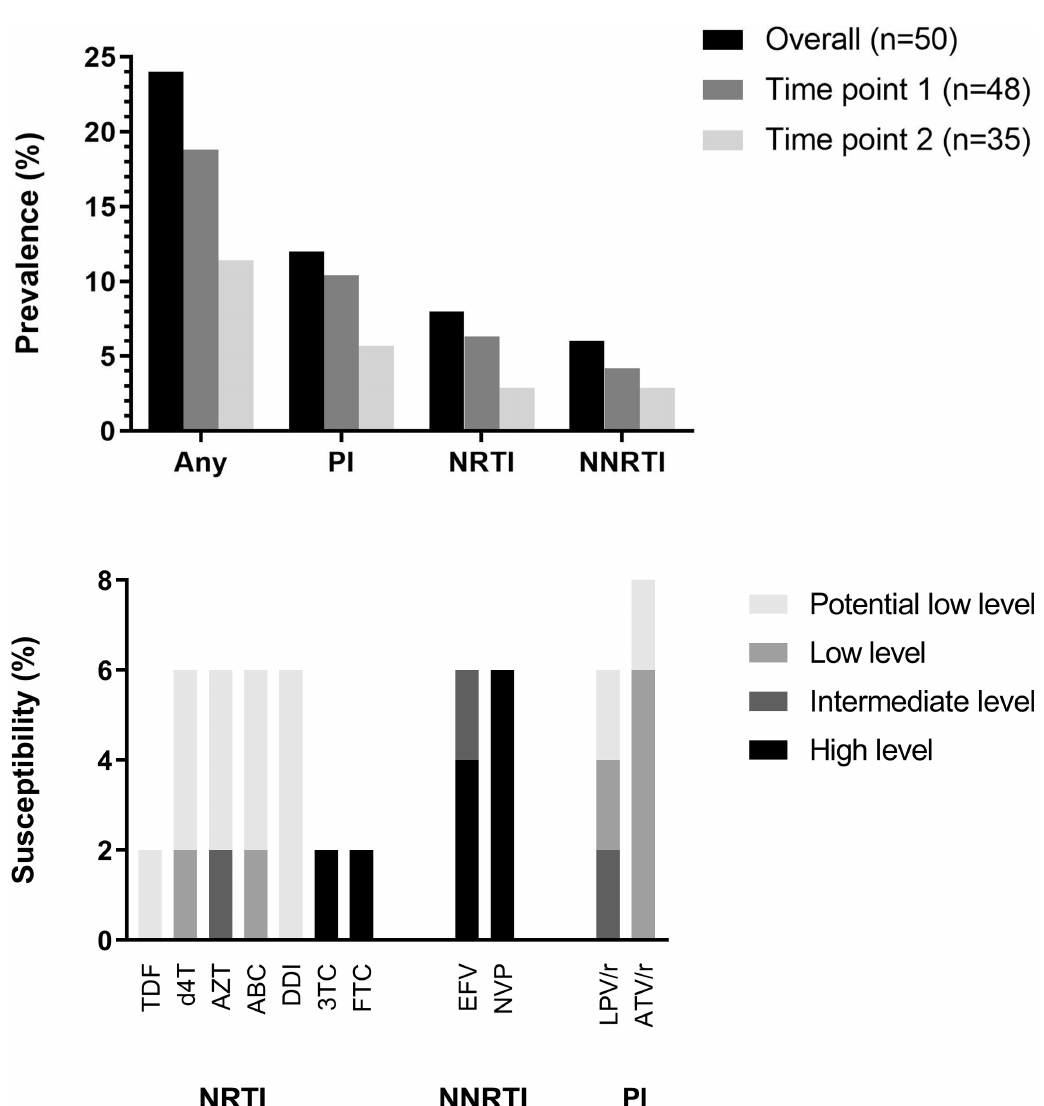
Fig 1. Bar graphs showing overall distribution of [a] HIV-1 drug resistance (HIVDR) variants by time points and drug classes, and [b] genotypic susceptibility of pre-treatment HIVDR variants detected by next generation sequencing from HIV infected antiretroviral-na ï ve individuals in a rural clinic in Coastal Kenya (n = 50) $ .